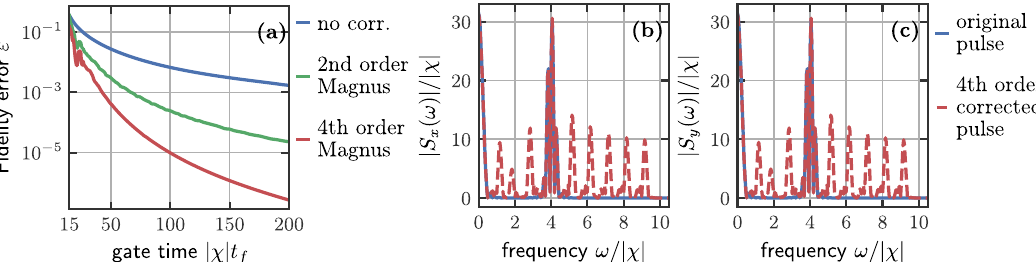
Fig. 6 Accelerated SNAP gates. a Average fi delity error for a snap operation. A π /2 phase is imprinted in the cavity energy levels 0 j i and 4 j i simultaneously. The blue trace is calculated with the uncorrected Hamiltonian. The green trace is obtained with the 2nd order corrected Hamiltonian. The red trace is obtained with the 4th order corrected Hamiltonian. b , c Spectrum of the x and y components of the original pulse envelope and of the 4th order corrected pulse envelope for ∣ χ ∣ t f = 50. The uncorrected envelope has peaks at ω = 0 and ω = 4 ∣ χ ∣ . The corrected pulse has peaks close to ω = 0, ∣ χ ∣ , … , 9 ∣ χ ∣ . This means that the corrected pulse simply undoes residual rotations caused by the nonresonant interaction in the different bosonic number-state subspaces in order to bring the fi nal state close to the target